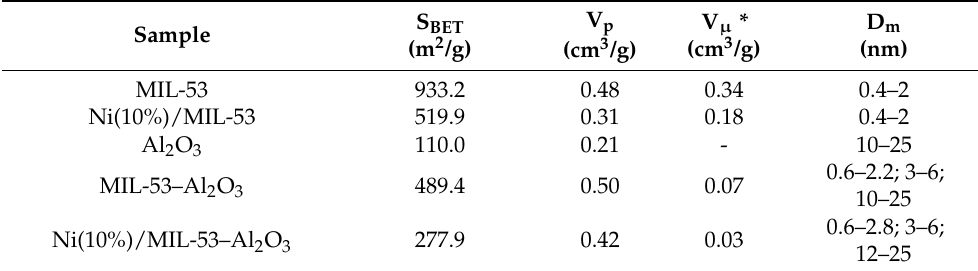
Figure 2. ( a ) Nitrogen adsorption–desorption isotherms and ( b ) pore size distribution for the MIL- 53-based samples. Table 1. Textural properties of the synthesized